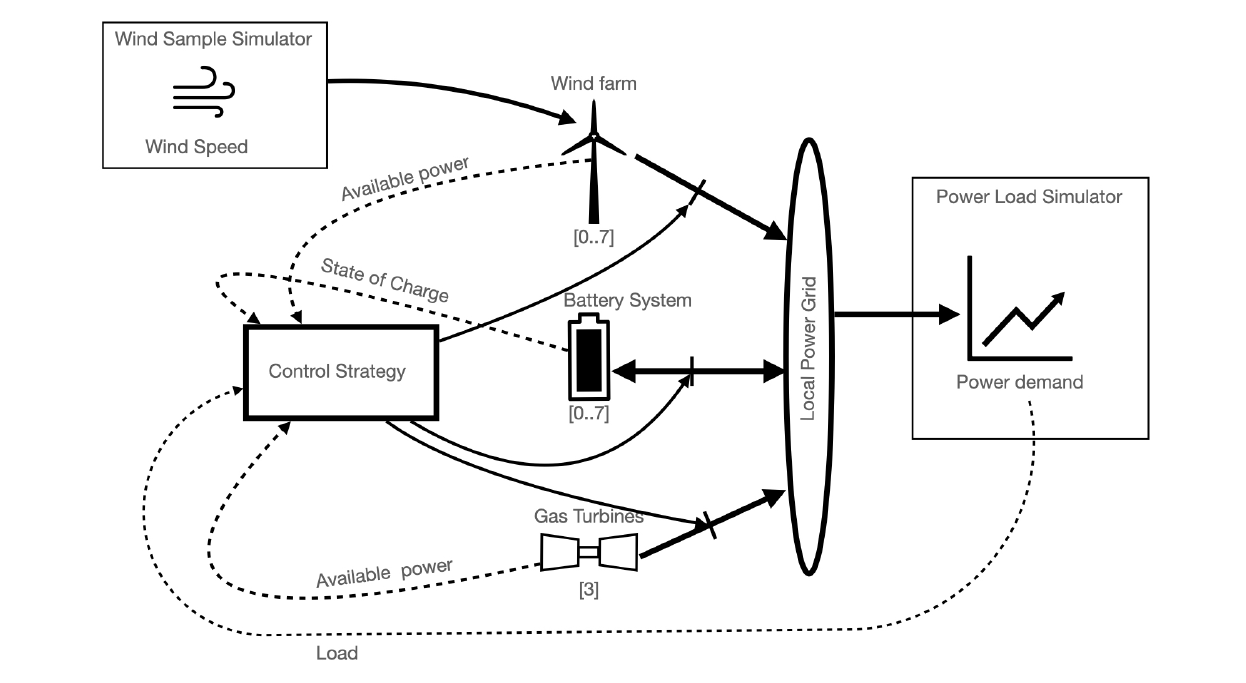
Figure 1. Overview of the micro-grid simulation